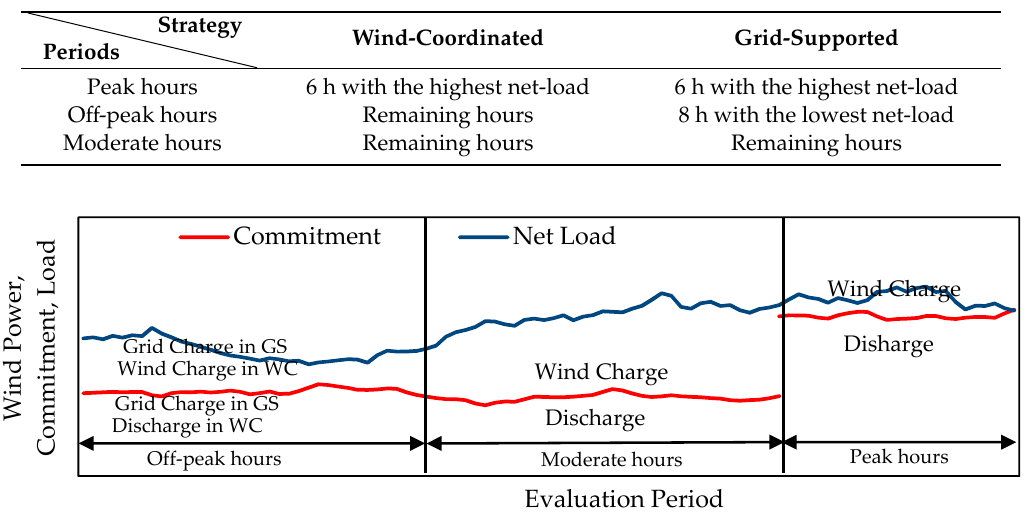
Figure 9. Wind generation and ESS coordination in grid-supported (GS) and wind-coordinated (WC) ESS operational strategies. Table 3. Different periods of operational strategies .